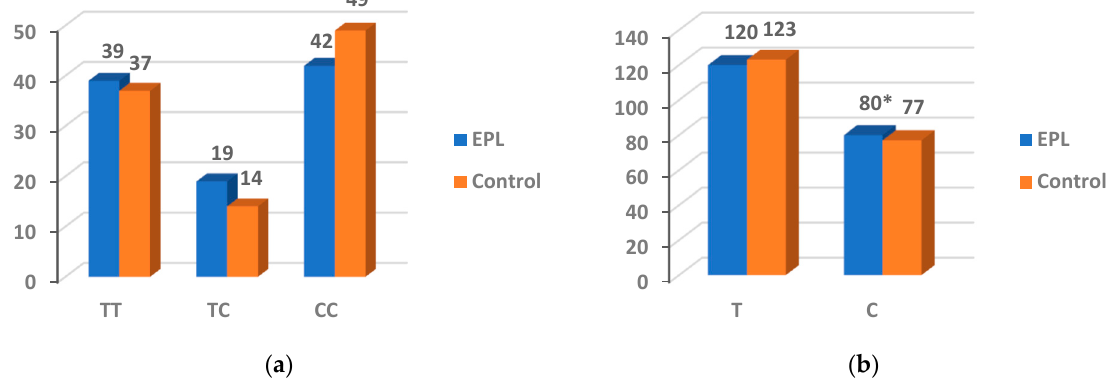
Figure 3. Genotype ( a ) and allele ( b ) frequencies for the PARP-1 V762A. * The difference was considered statistically significant ( p < 0.05).